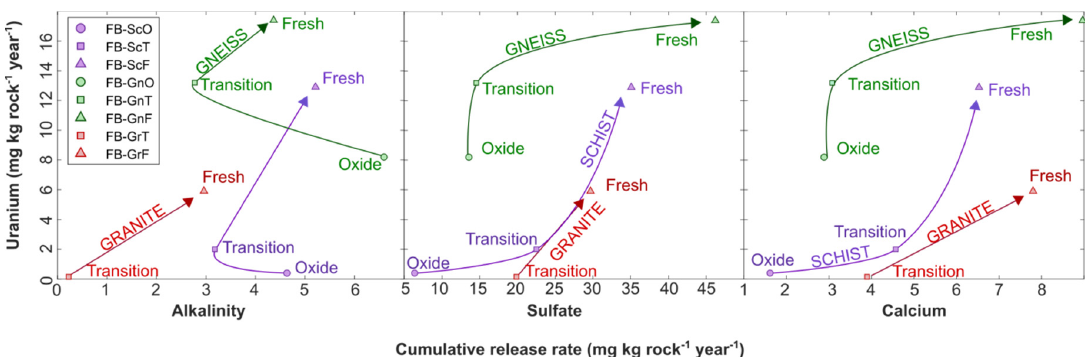
Figure 6. Cumulative U release rate in field-bin experiments against release rates of alkalinity ( left ), sulfate ( middle ) and calcium ( right ). Arrows indicate trend from oxide to transition to fresh weathering facies in each rock type.